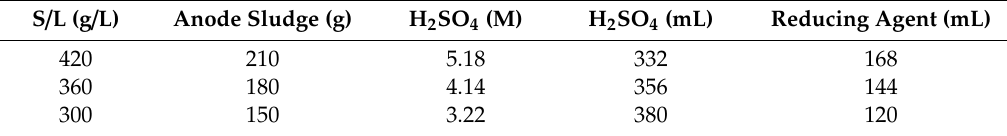
Table 2. Experimental parameters for each solid-to-liquid ratio.